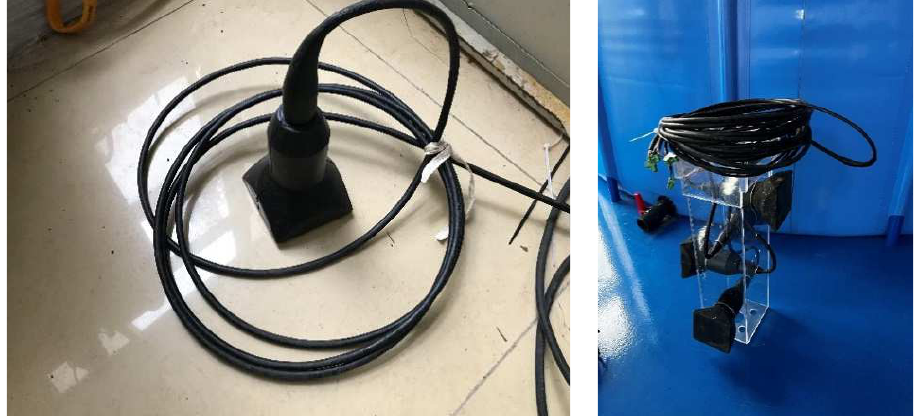
Figure 2. Proposed ultrasonic transducer.